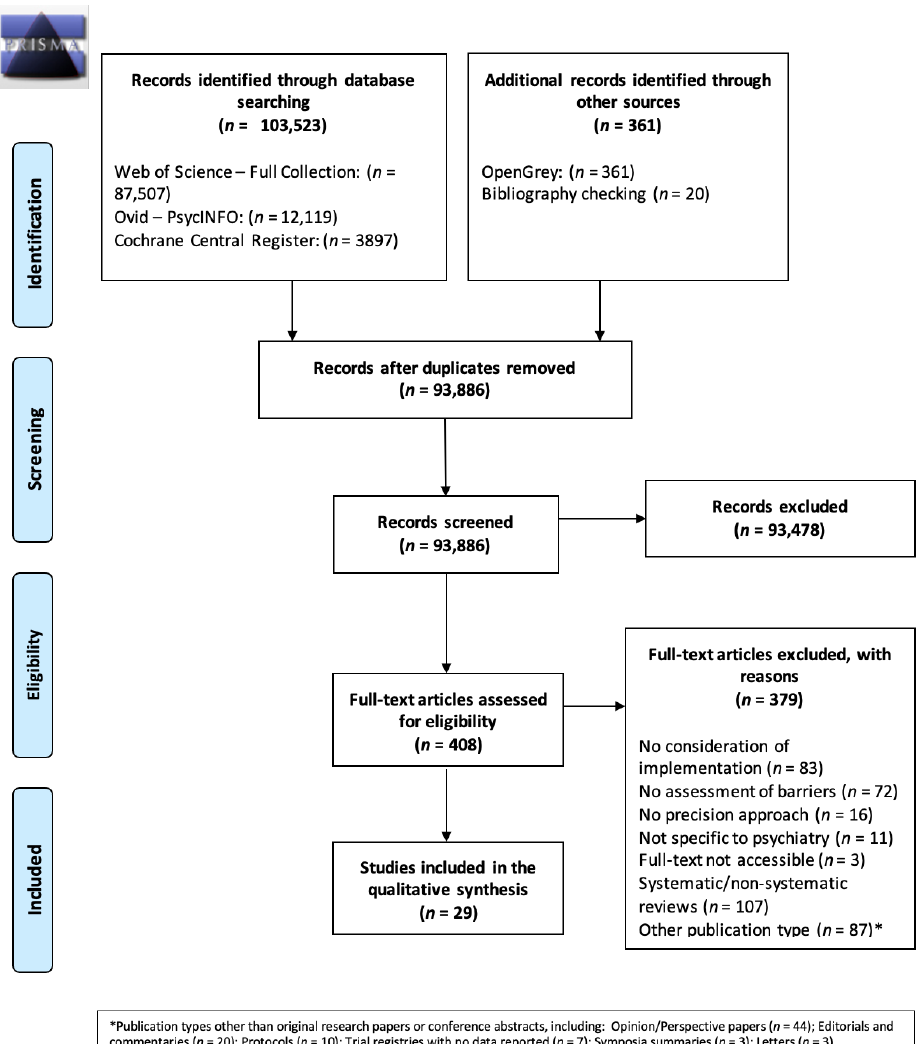
Figure 1. Preferred reporting items for systematic reviews and meta-analyses (PRISMA) diagram detailing the full study selection